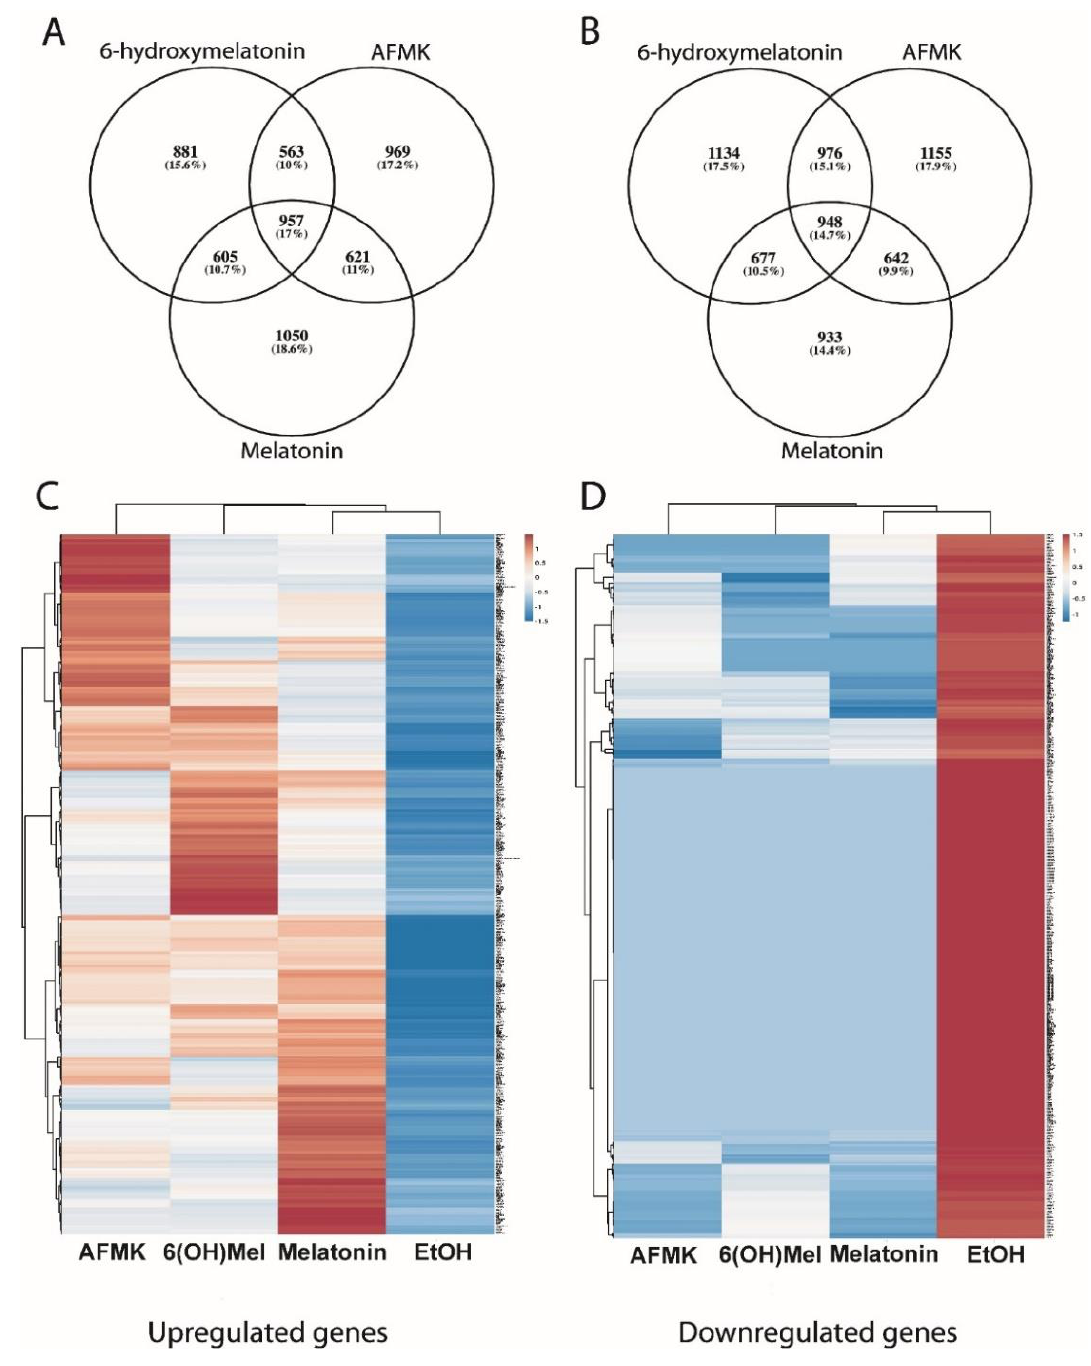
Figure 1. Analyses of differentially expressed genes in human keratinocytes treated with melatonin, 6-hydroxymelatonin and AFMK. Venn diagrams are in ( A ) for up- and in ( B ) for downregulated genes. Heatmaps for all upregulated genes are in ( C ) and for downregulated genes in ( D ), which are common for all tested compounds. Keratinocytes were treated with 10 −5 M of melatonin, its metabolites or vehicle for 24 h and submitted for RNA- sequence analysis.